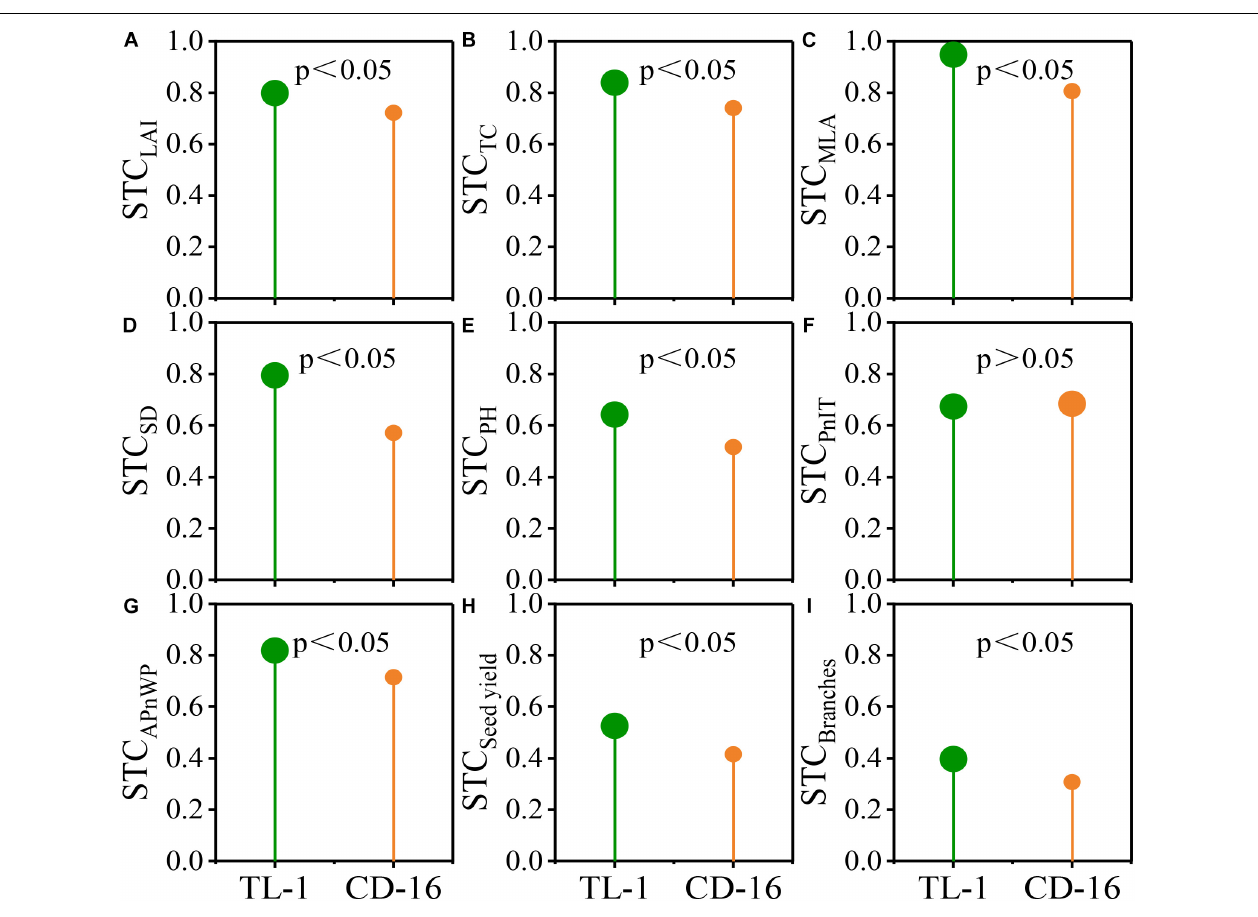
FIGURE 10 | Evaluation of shade-tolerance target traits such as LAI (A) , TC (B) , MLA (C) , SD (D) , PH (E) , the PnIT (F) , the APnWP, (G) , seed yield (H) , and branches (I) in soybean at the levels of p ≤